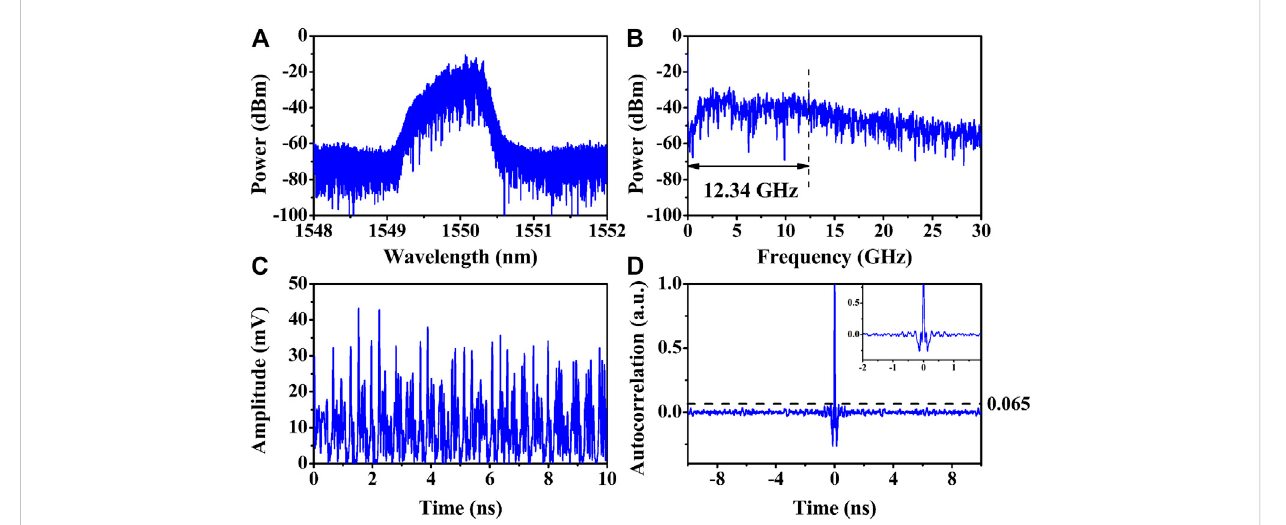
FIGURE 3 Typical chaotic laser state of (A) optical spectrum; (B) power spectrum; (C) time domain series; and (D) auto-correlation function at I DFB = 50.0 mA, I I Phase = 16.0 mA, and DBR = 8.0 mA.